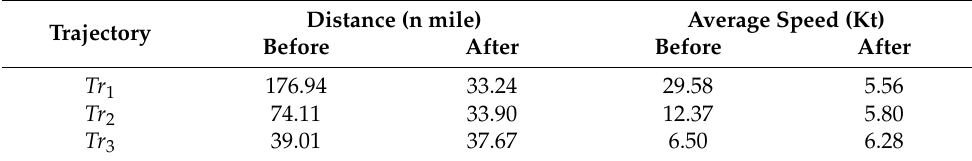
Table 5. Trajectory